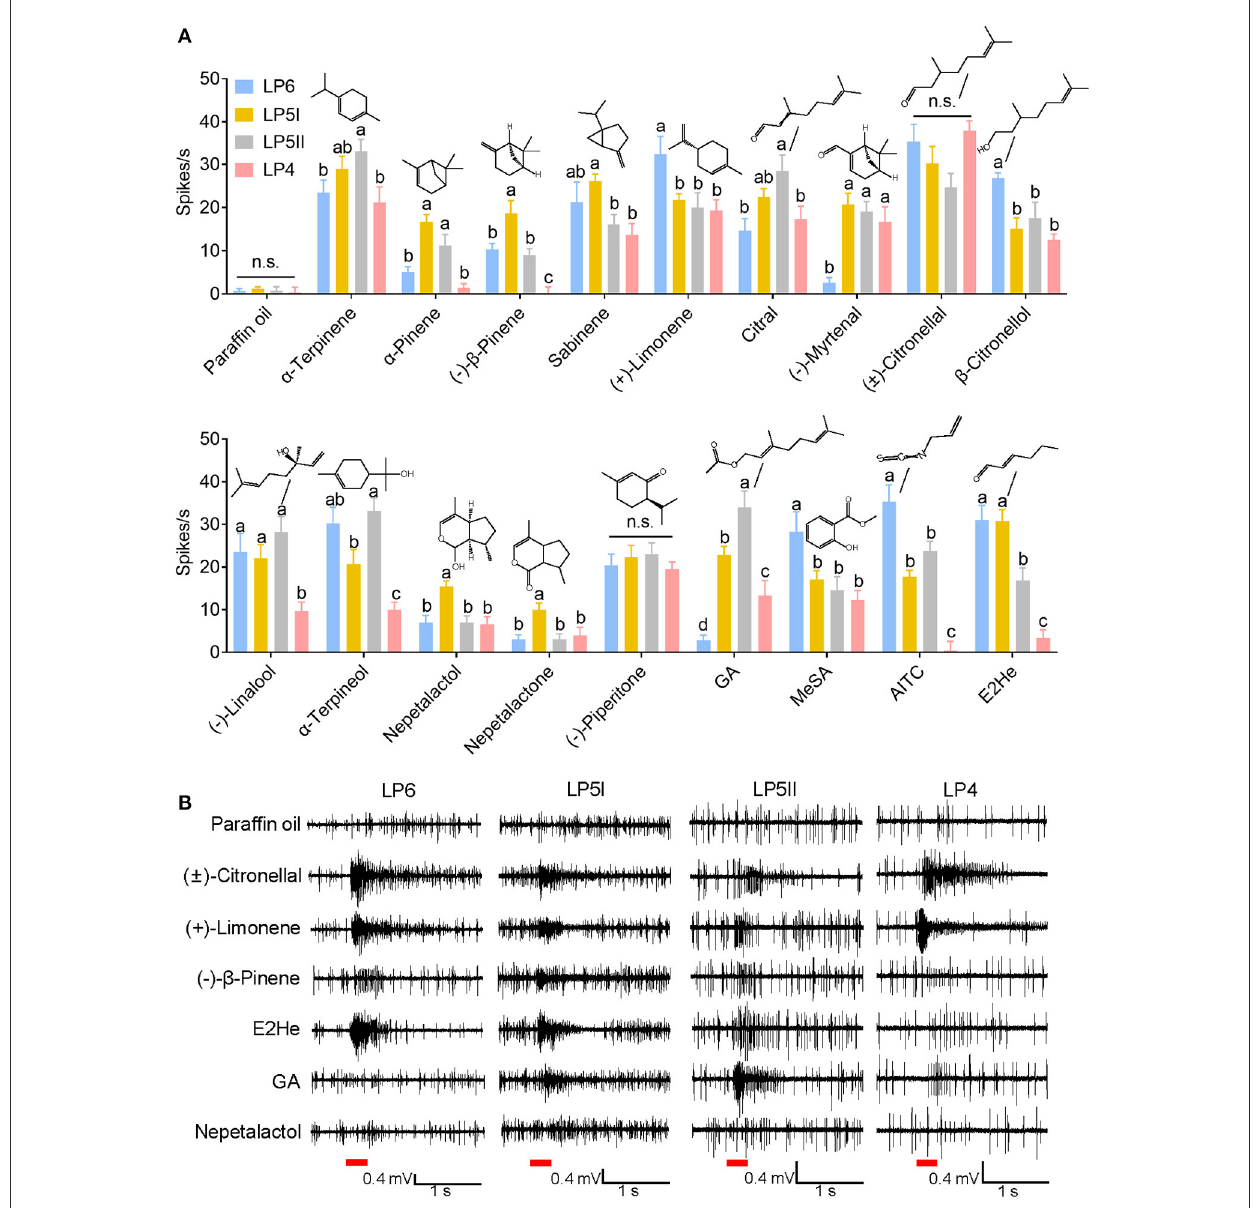
FIGURE5 SSR response values of ORNs in antennal placoid sensilla of C. cedri to the tested odorants. (A) Neuronal responses of LP4, LP5I, LP5II, and LP6 of C. cedri . Bars labeled with different letters are significantly different (mean ± SEM, n = 4–16, GLM followed by Duncan’s multiple range test). (B) Representative SSR traces showing responses of ORNs in LP4, LP5I, LP5II, and LP6 of C. cedri to ( ± )-citronellal, ( + )-limonene, (–)- β -pinene, E2He, GA, and nepetalactol. Paraffin oil was used as a control. Chemicals were tested at a dose of 10 − 3 g. Red bars indicate the 300ms stimulation of odorants. E2He, trans -2-hexenal; MeSA, methyl salicylate; AITC, allyl isothiocyanate; GA, geranyl